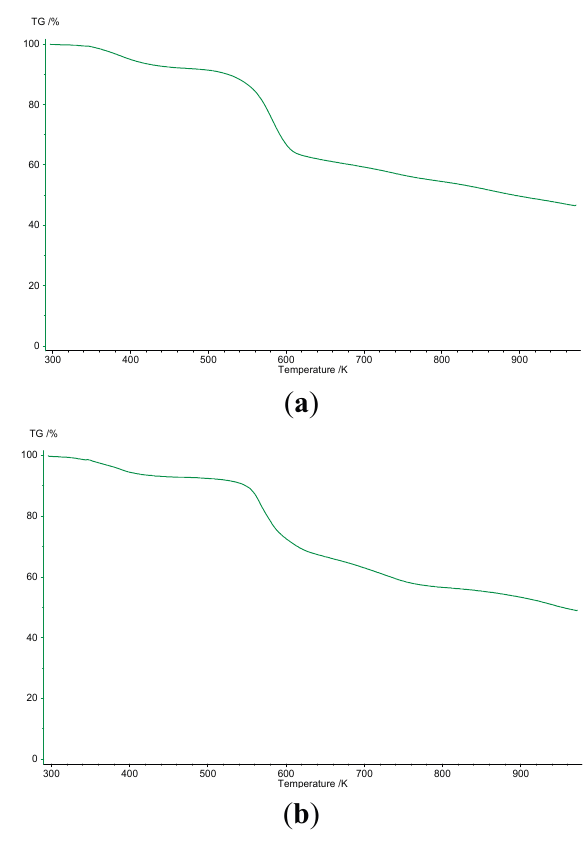
Figure 1. Thermograms of sulfonated resorcinarenes: ( a ) Compound 2a ; ( b ) Compound 2b . Our attempts to grow crystals for Compound 2b were unsuccessful, whereas crystals suitable for a single-crystal X-ray diffraction analysis for Compound 2a were obtained from a water-acetone (1:1) solution. Compound 2a crystallizes with eight molecules of water and two molecules of acetone as a one-dimensional coordination polymer. These crystals decompose when they are exposed to air, very likely due to the loss of solvent, but they are stable in solution. The asymmetric unit of 2a is shown in Figure 2, while the values of both the selected lengths and the angles are given in Table 2.